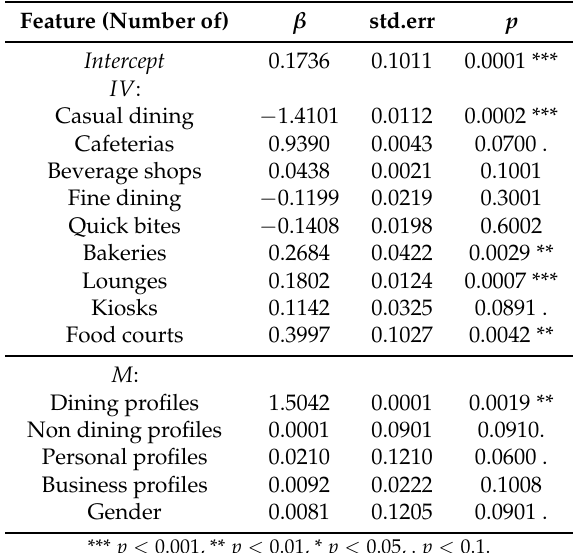
Table A4. Summary of regression results of mediation analysis: independent variables ( IV ), mediator variable ( M ) and dependent variable ( DV ) being total dining posts ( DV total ). The results for IV are presented with Dining profiles as the mediator